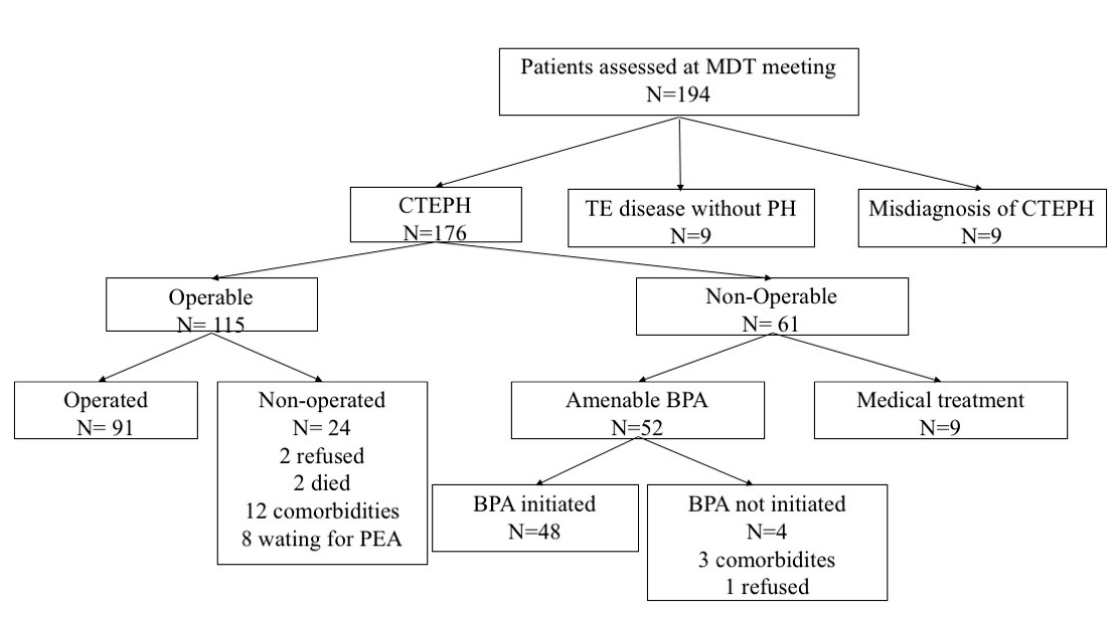
Figure 4. Patients’ disposition according to final treatment.